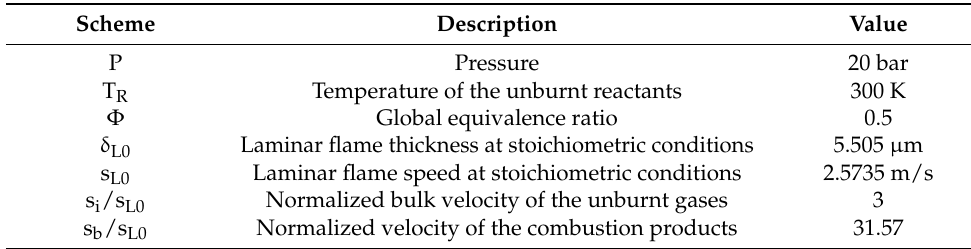
Table 2. Combustion